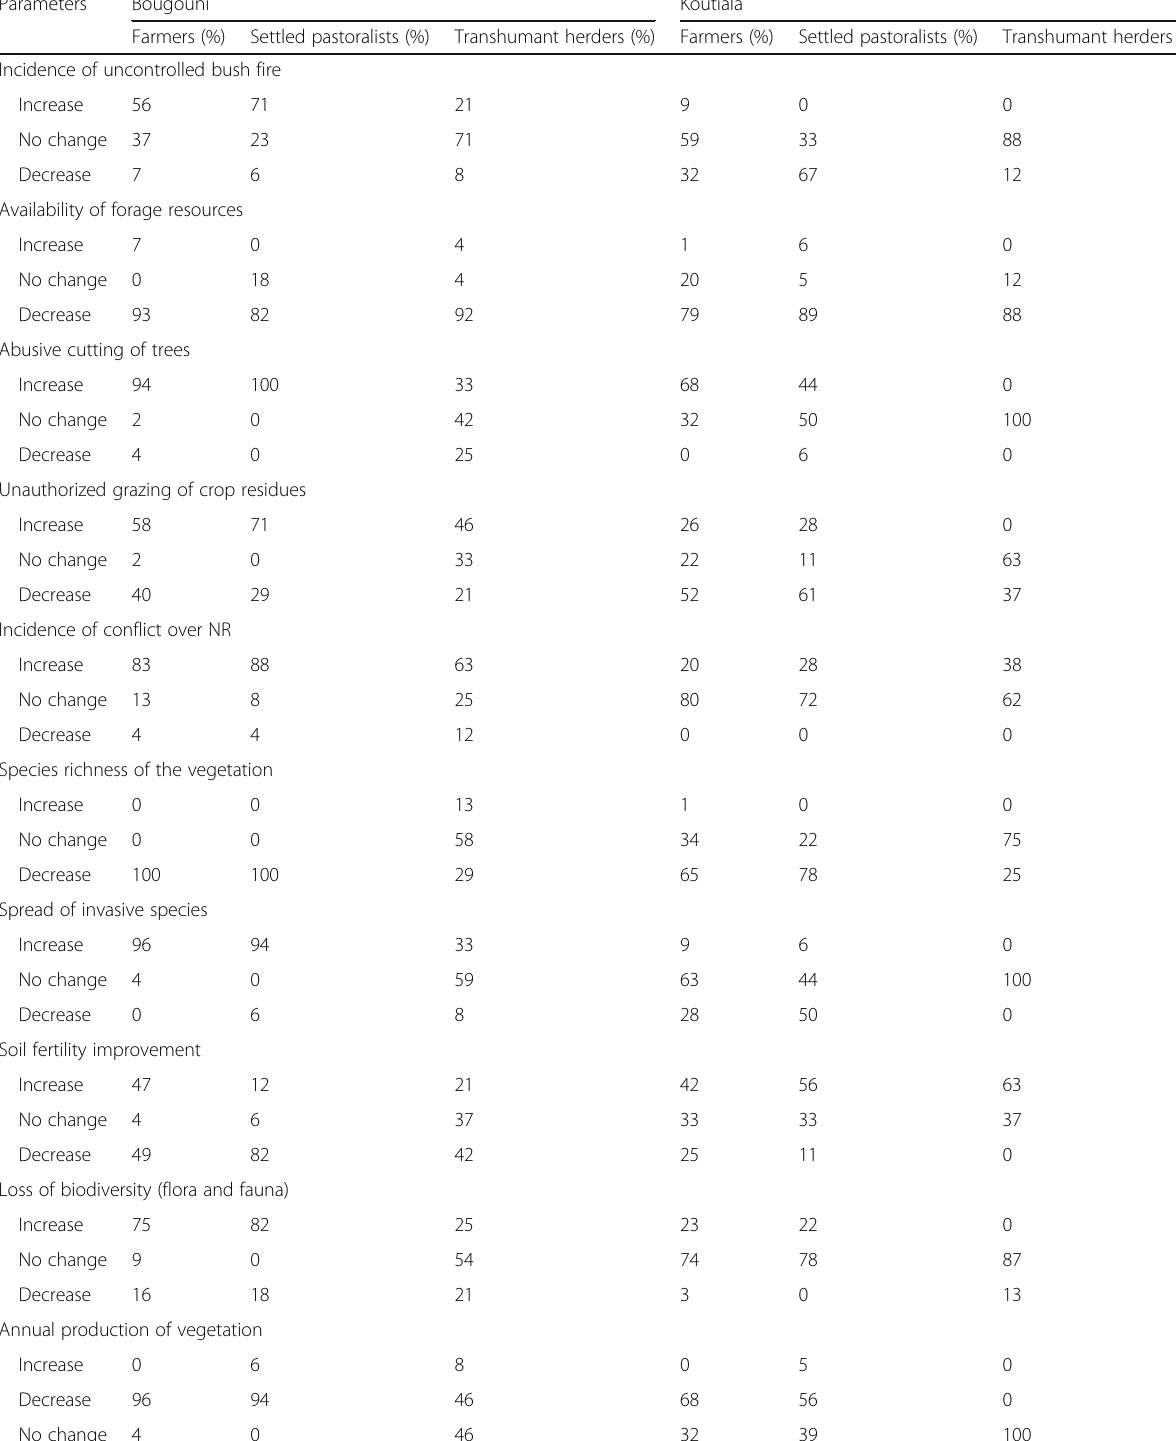
Table 3 Respondents ’ perceptions of impact of transhumant practices on NRM in southern Mali Parameters Bougouni